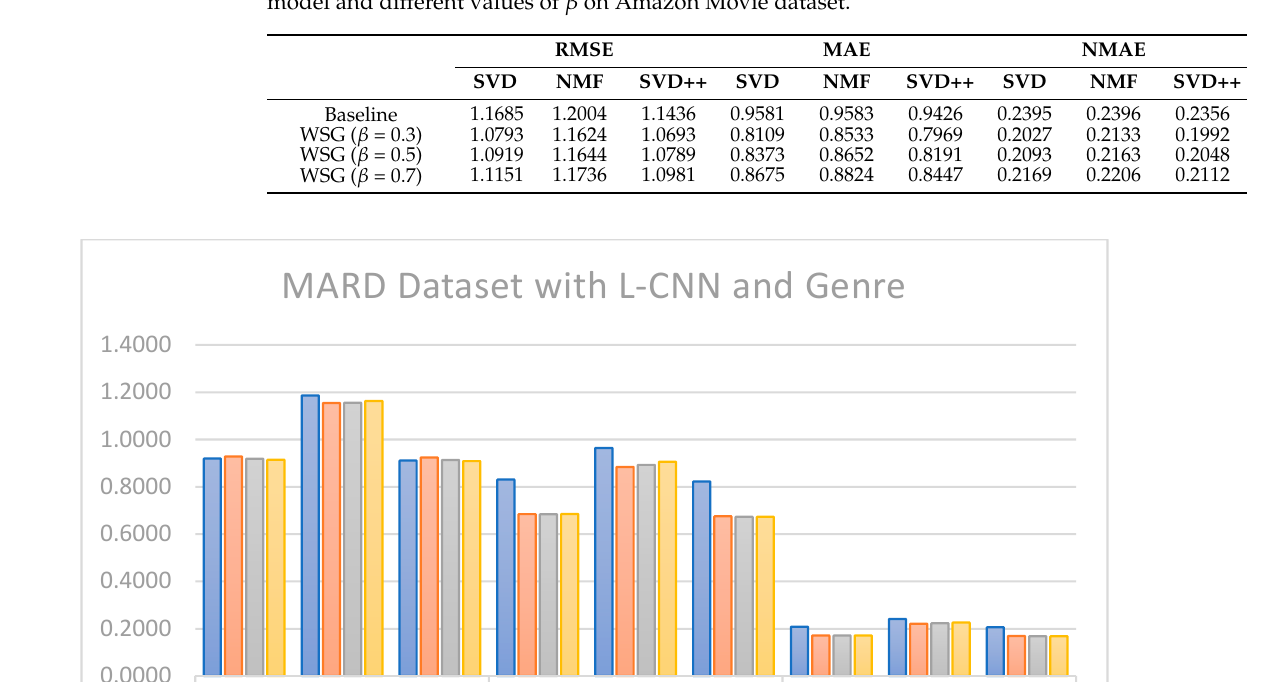
Figure 8. RMSE (Root-Mean-Square Error), MAE (Mean Absolute Error), and NMAE (Normalized MAE) values with and without L-CNN sentiment and genres-based model and different values of β on the MARD dataset. Table 6. RMSE, MAE, and NMAE values with and without C-LSTM sentiment and genres-based model and different values of β on the MARD dataset.